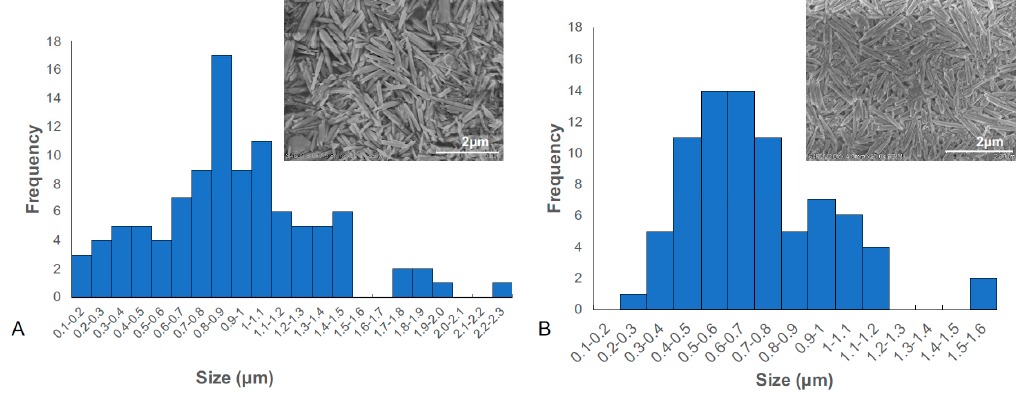
Figure 4. Histogram graph of size distribution of long HNTs ( A ) and shortened HNTs ( B ).